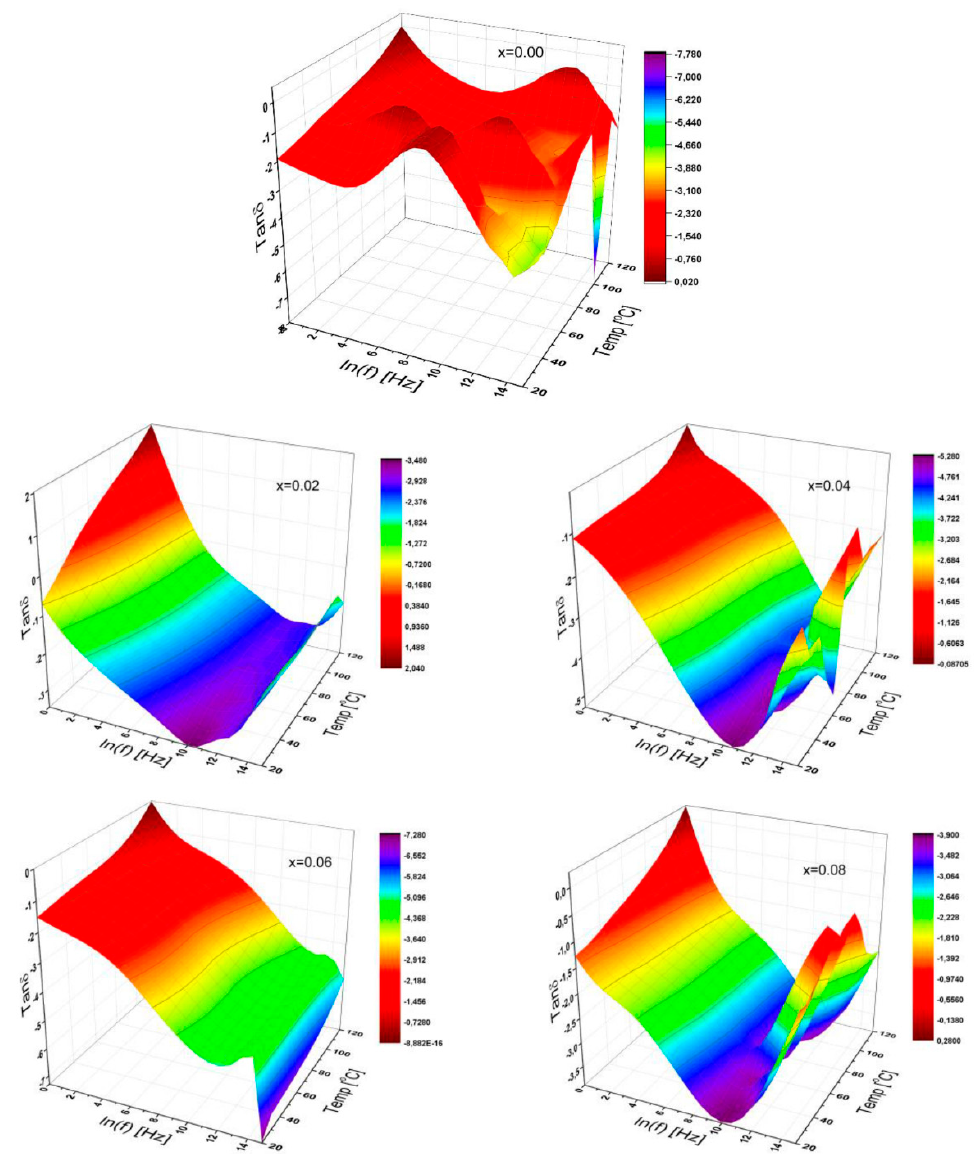
Figure 9. 3D characteristic plots of dielectric tangent loss of SrNb x Fe 12 − x O 19 (0.00 ≤ x ≤ 0.08) HFs for a variety of substitutional Nb ions ratio as functions of frequency up to 3 MHz, and for temperatures up to 120 °C.